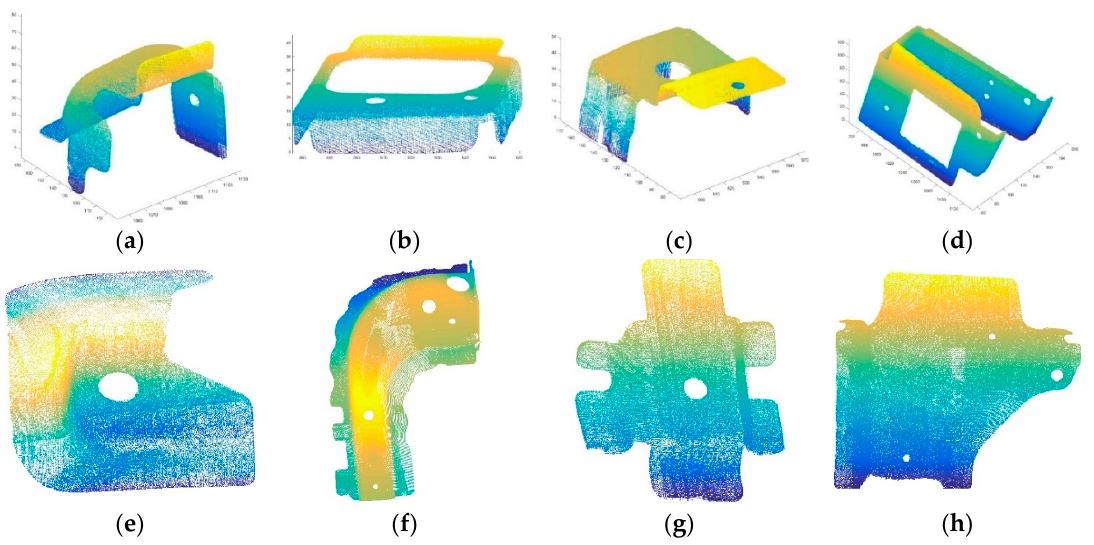
Figure 9. PCD after denoising. ( a )–( h ) are a series of denoising results of vehicle body parts PCD in Figure 3, respectively.